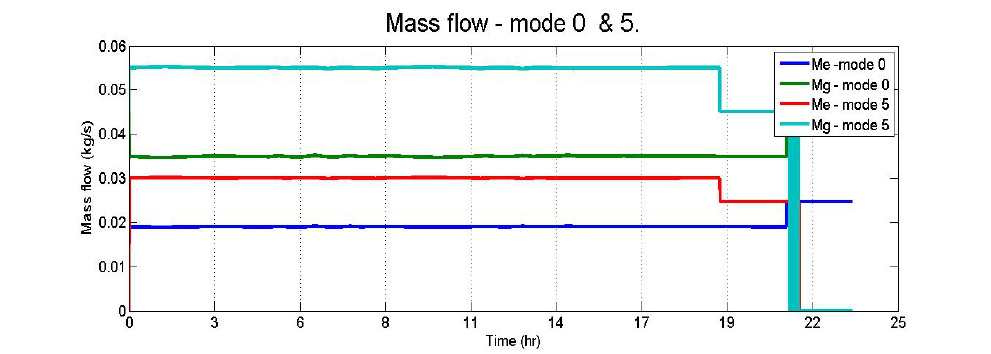
Figure 22. Mass flow for Modes 0 and 5.